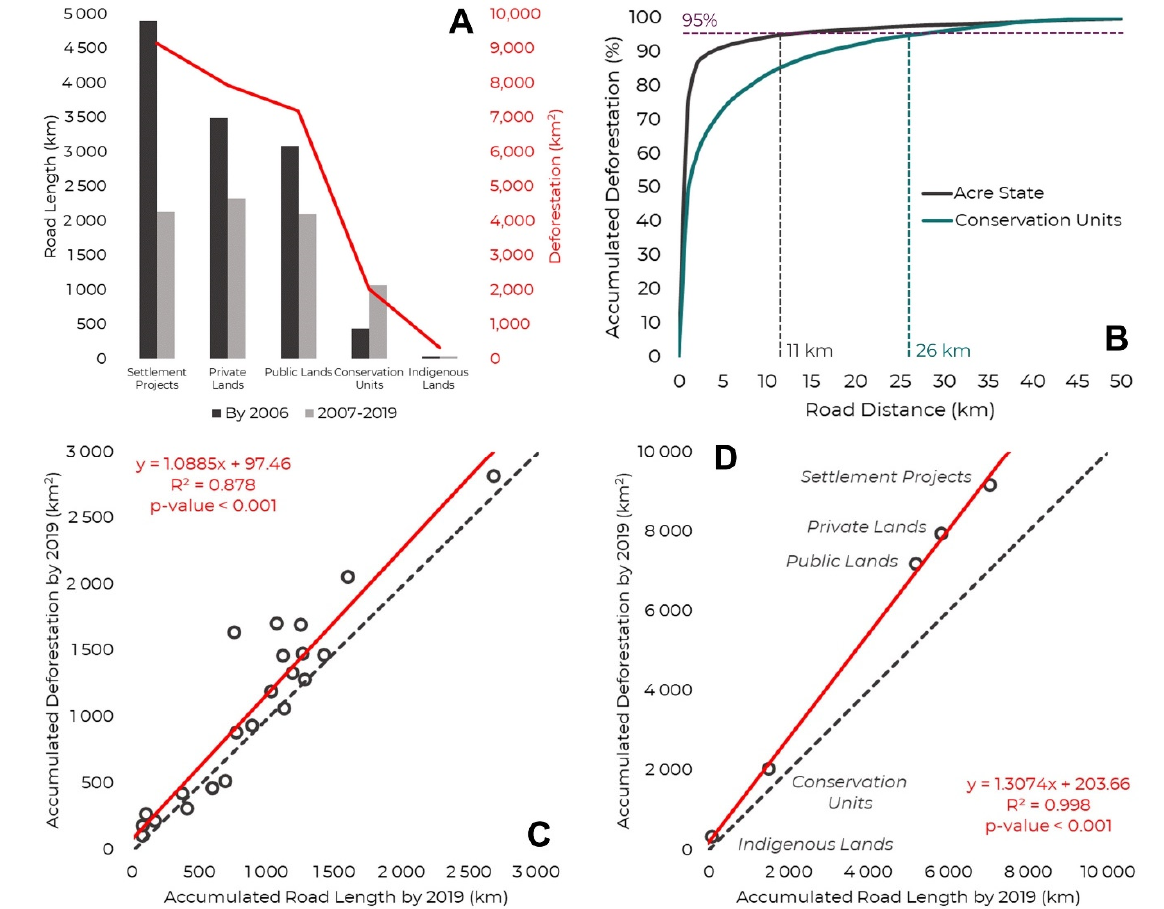
Figure 4. ( A ) Roads and land class relations in Acre. ( B ) Percentage accumulation of total deforestation until 2019 for the State of Acre and Conservation Units as a function of distance from the road axes. Dashed lines indicate the distance from the road when 95% of deforestation accumulates for each unit, black line—State of Acre, and green line—Conservation Units. ( C ) Relationship between road extension until 2019 with deforestation until 2019 in the State of Acre. Each point represents a municipality. ( D ) Relationship between road extension until 2019 with deforestation by land class until 2019. The dashed black line in Figure 4C,D is the 1:1 line.